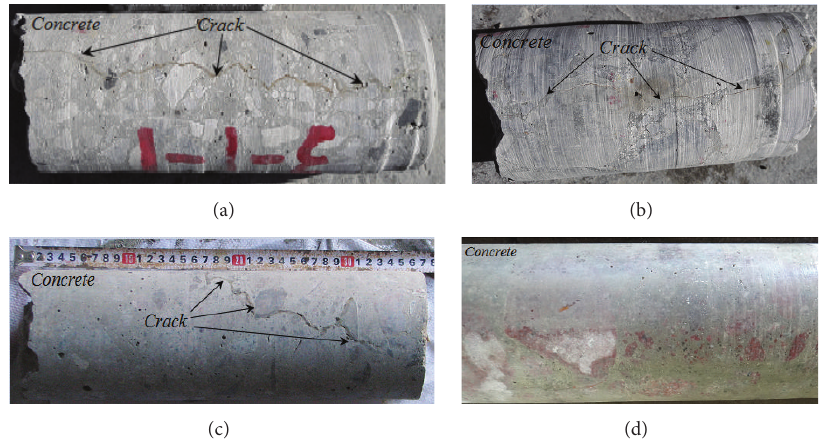
Figure 12: Concrete specimens: (a) Tt10-102, (b) Tt17-74, (c) Tt13-67, and (d)